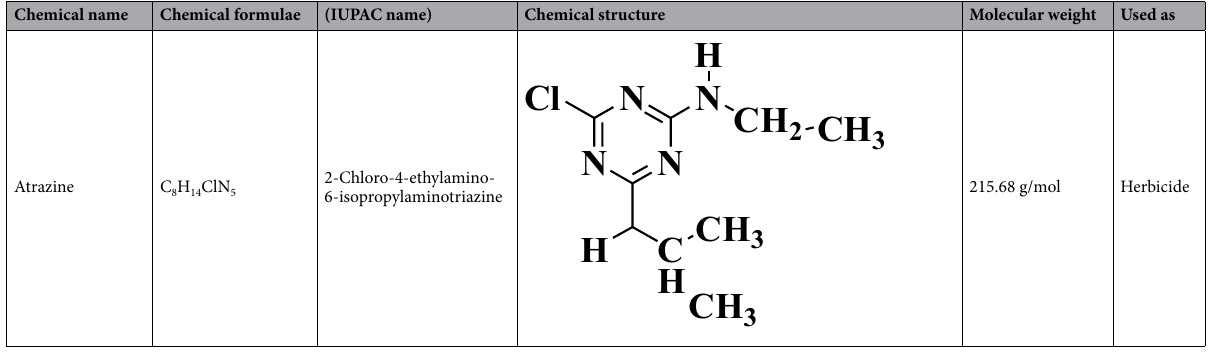
Table 1. Some chemical properties of